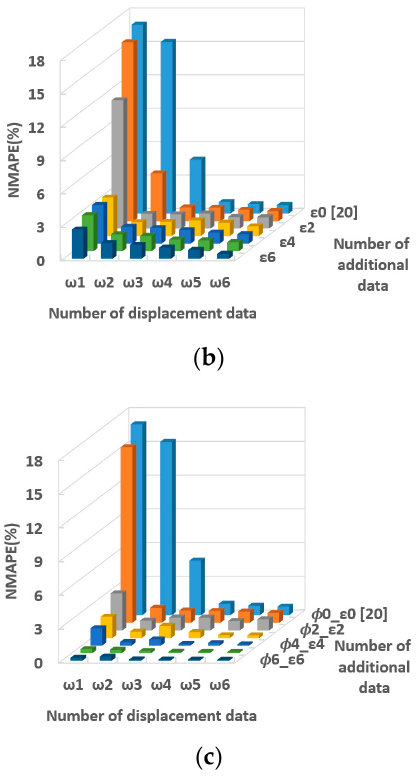
Figure 20. NMAPE according to the number and combination of sensors (RDS1): ( a ) displacement + slope, ( b ) displacement + strain, ( c ) displacement + slope + strain.